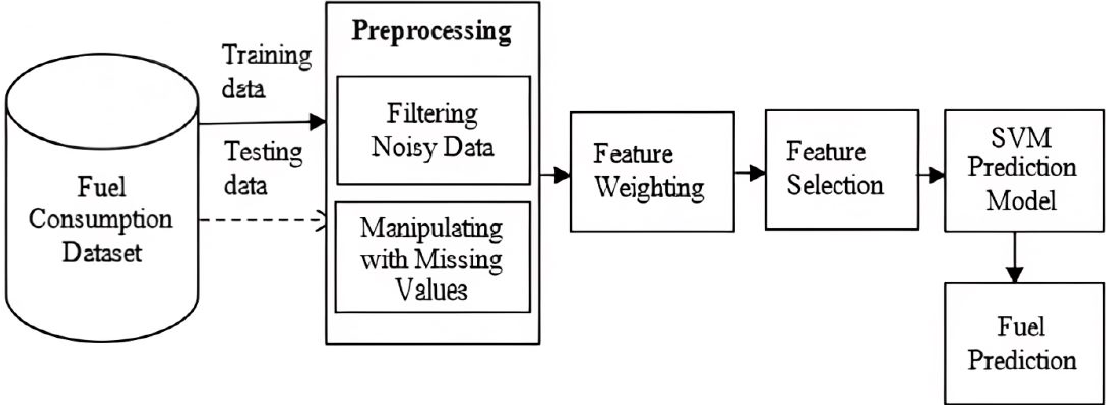
Figure 5. A Proposed model diagram in [34].